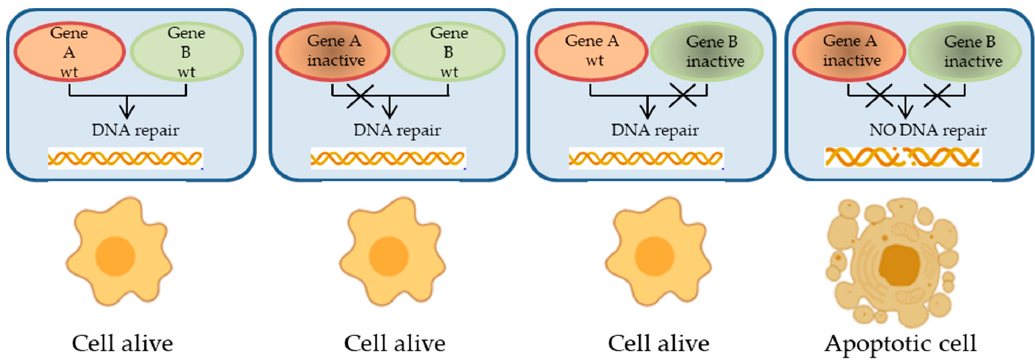
Figure 2. Schematic illustration of synthetic lethality. The concomitant alteration of two